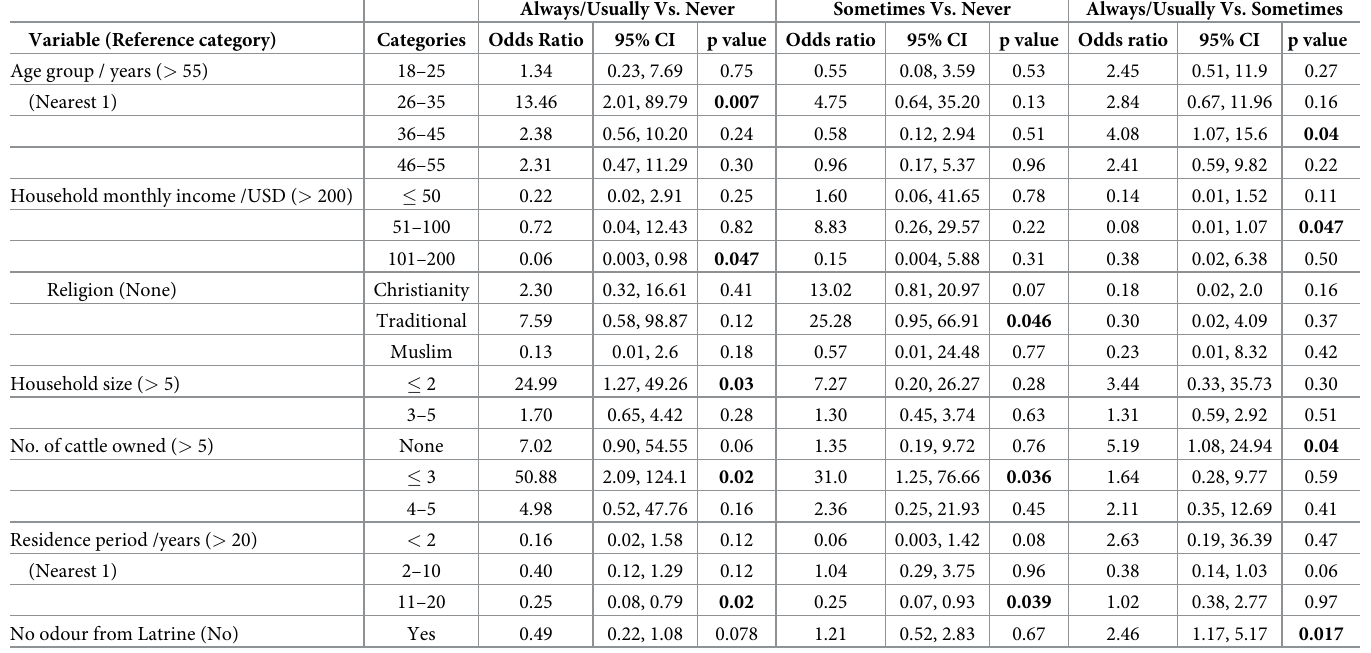
Table 3. Parameter estimates of the multinomial logit latrine use model showing the effect of individual, household and technology-level predictors on sustained use a BVIP latrine rural households in Mbire district, northern Zimbabwe (n = 238). Always/Usually Vs. Never Sometimes Vs. Never Always/Usually Vs. Sometimes